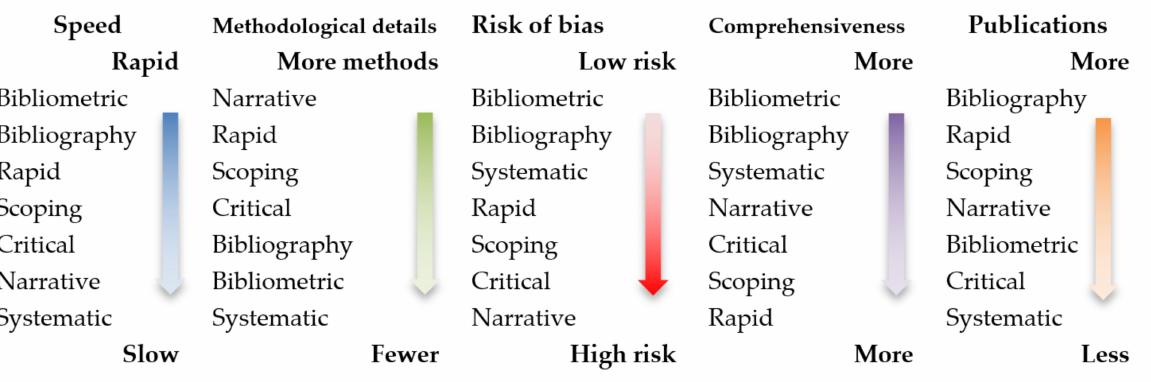
Figure 1. Schematic of the main differences between the types of literature